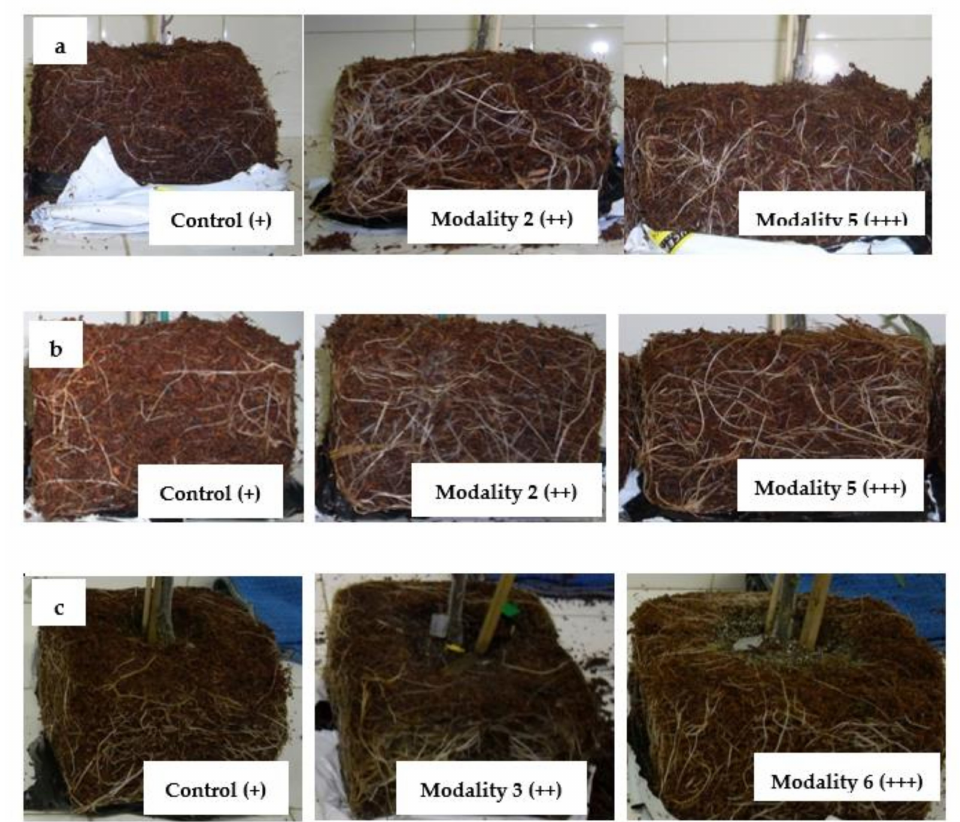
Figure 3. Pictures showing the different types of root development (+, ++, +++) observed in clods, ( a ) 4 weeks after planting, ( b ) 6 weeks after planting and ( c ) 8 weeks after planting.